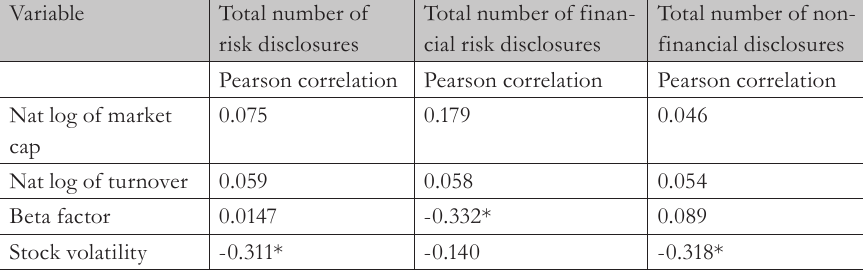
Tab. 3 – Pearson correlation coefficients for variables. Source: own